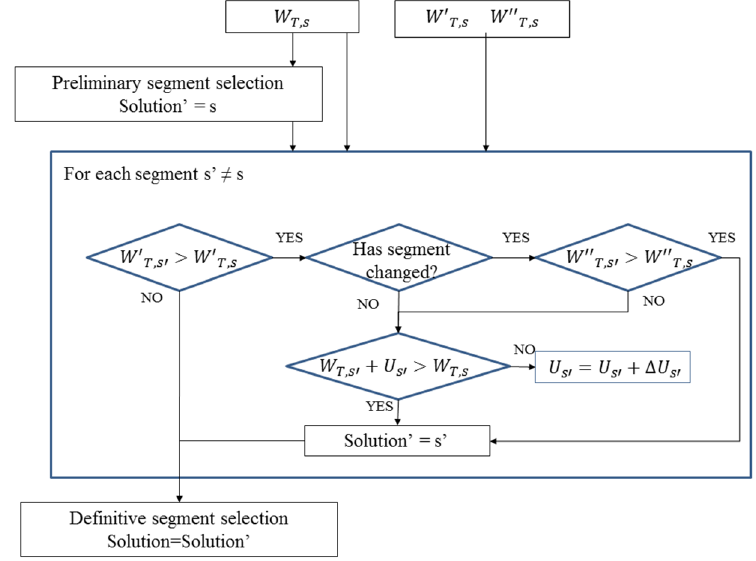
Figure 1. Preliminary segment verification algorithm.